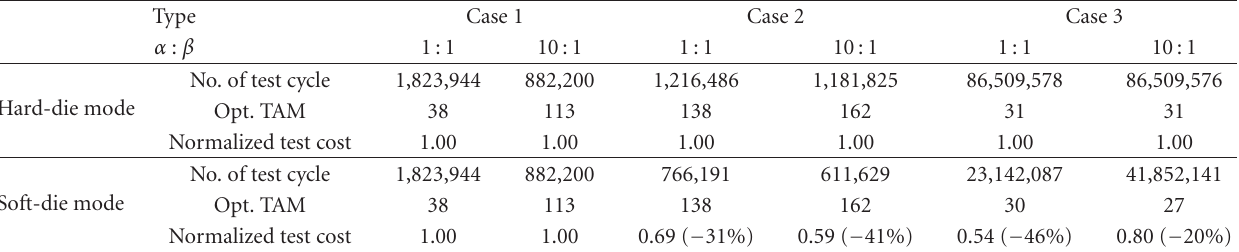
Table 4: Results of soft-die mode.